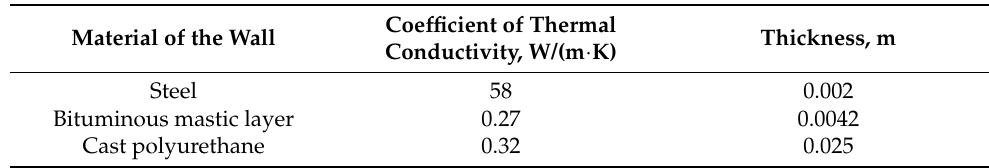
Table 1. Composite wall options.